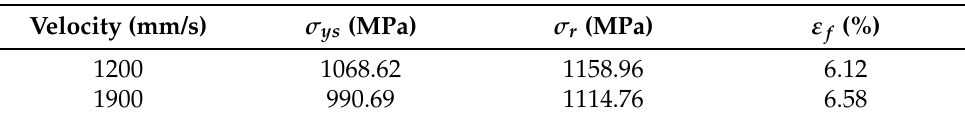
Figure 7. Engineering stress vs. strain curves for Ti-6Al-4V for two velocities: 1200 and 1900 mm/s. Table 4. Tensile properties for additively manufactured Ti-6Al-4V obtained from the stress–strain curves in Figure